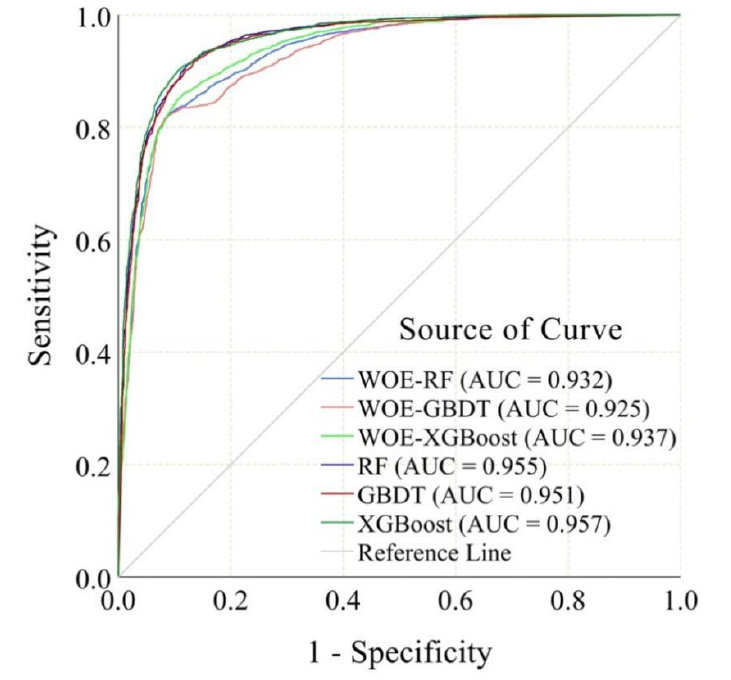
Figure 7. The receiver operating characteristic (ROC) curve using testing data.